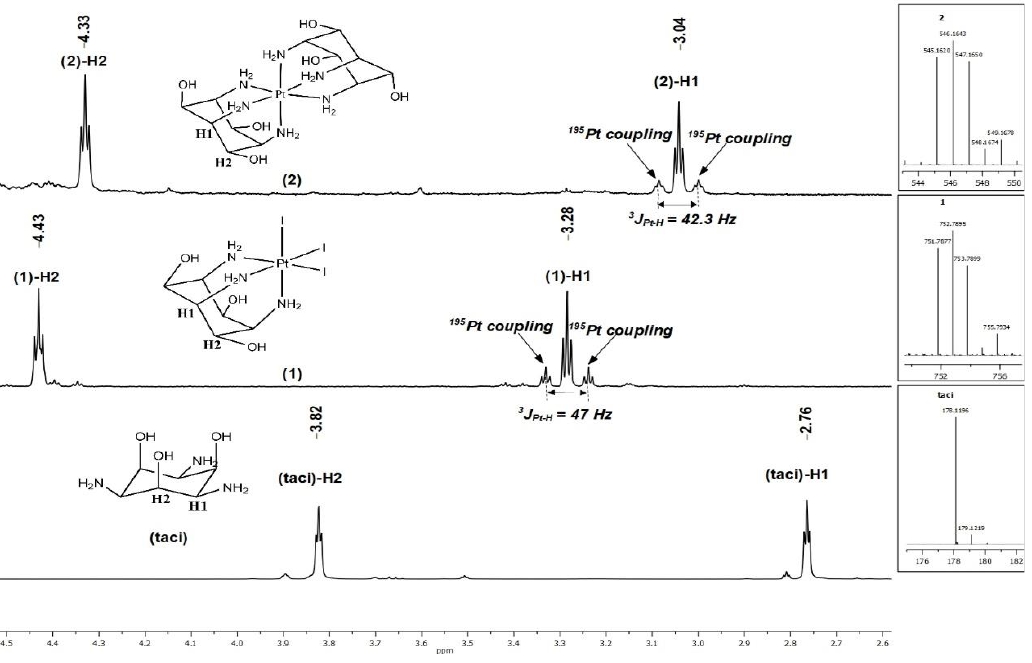
Figure 4. 1 H NMR spectra of taci, 1 and 2 in D 2 O and corresponding HR- ESI(+)−MS signals (H 2 O).